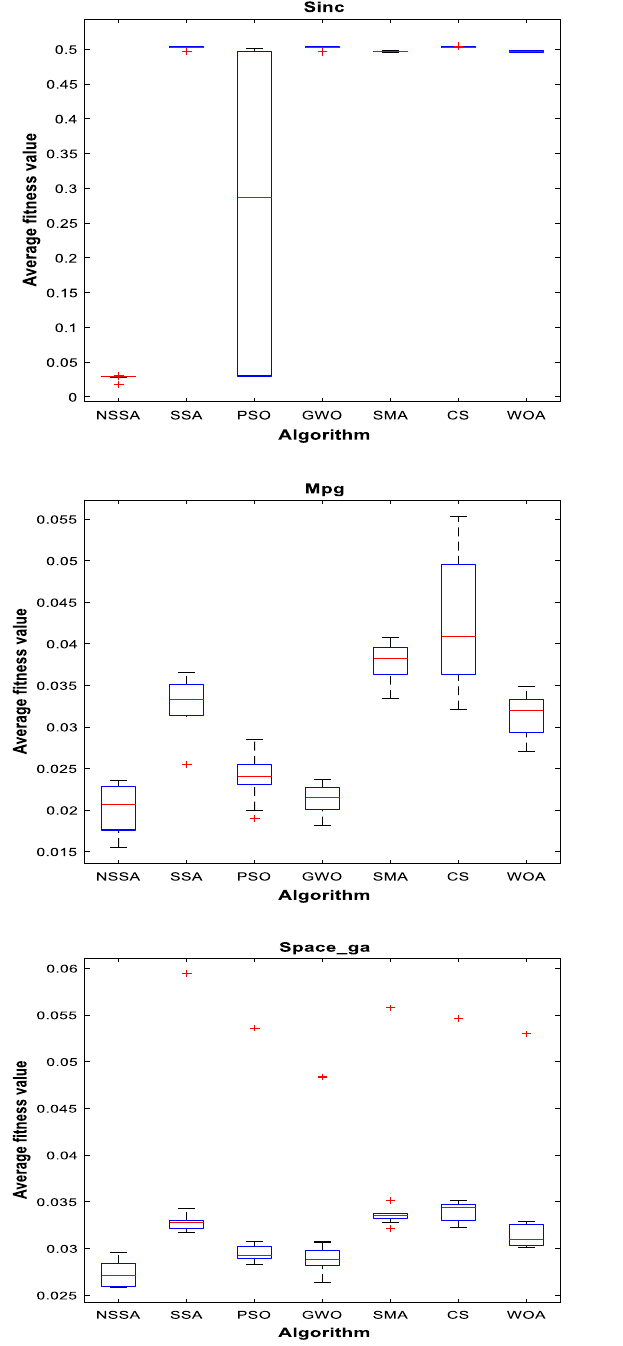
Fig. 7 Variance diagram during regression